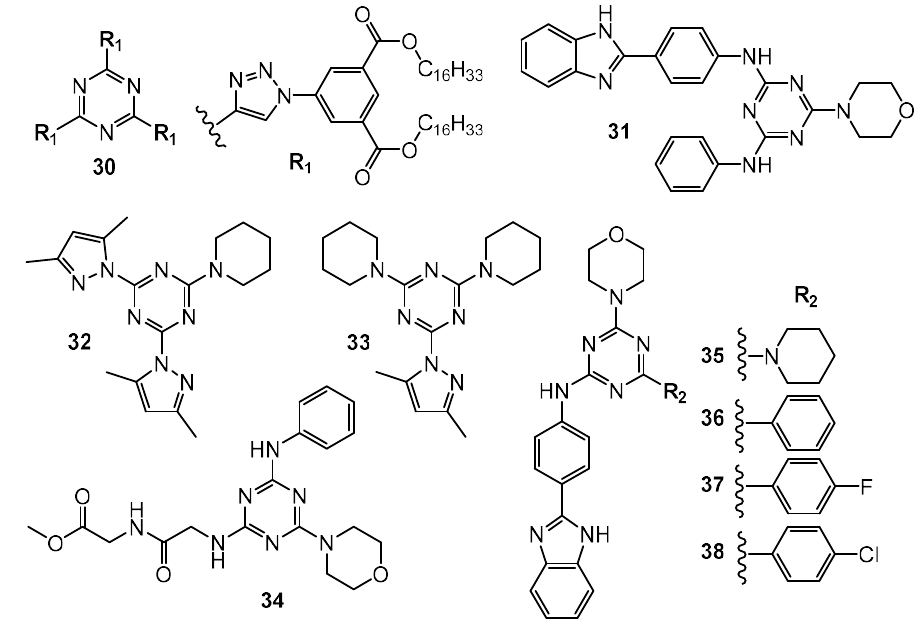
Figure 9. Structures of compounds 30–38 .